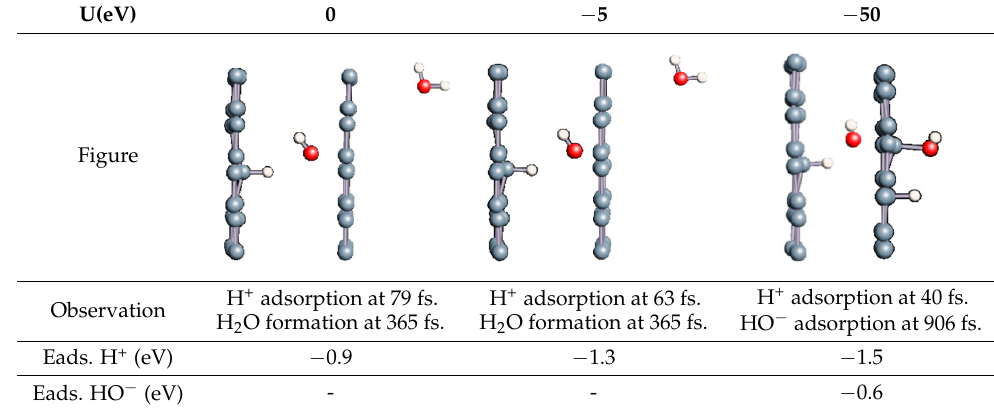
Figure 2. Charge density distribution in the case of dissociated water molecule adsorption on gra- phene at − 50 eV electric field. Yellow and blue lobes represent, respectively, the positively and negatively charged areas.